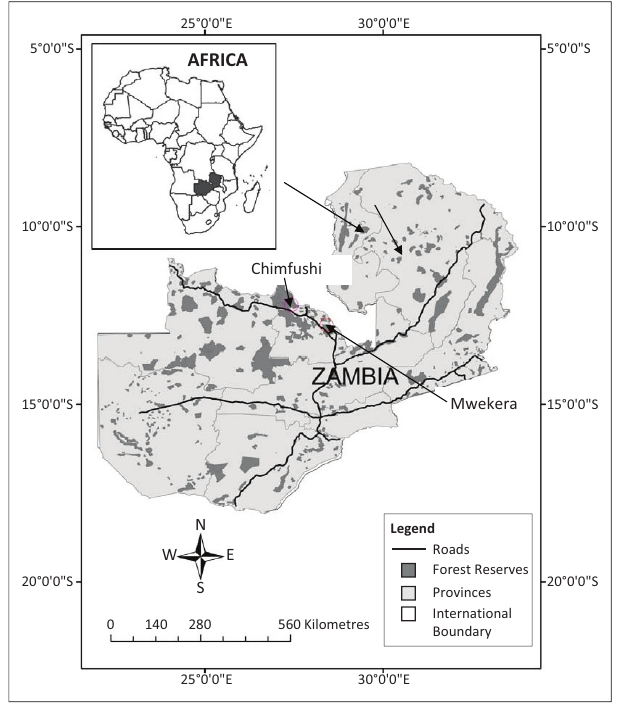
FIGURE 1: Locations of Mwekera National Forests No. 6 and Chimfushi Wildlife Orphanage forests in